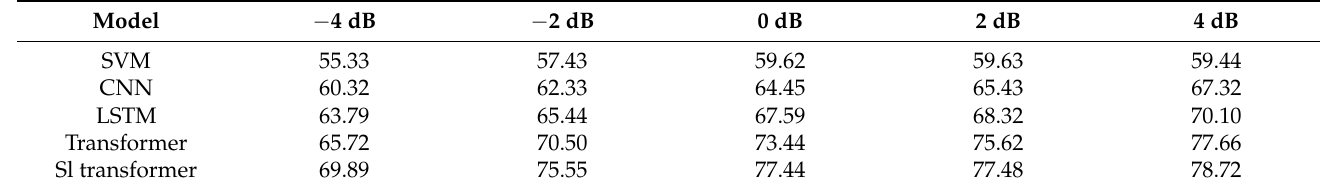
Figure 17. The accuracy graph of applying SSA algorithm for noise data. Table 7 is composed of scenarios assuming situations in which the application of this experiment is required. The problem situations that usually occur in existing factories can be seen in before, and the situation that is solved through SSA-Sl transformer can be seen in after. Table 3. The accuracy table of non-applying SSA algorithm for noise data.